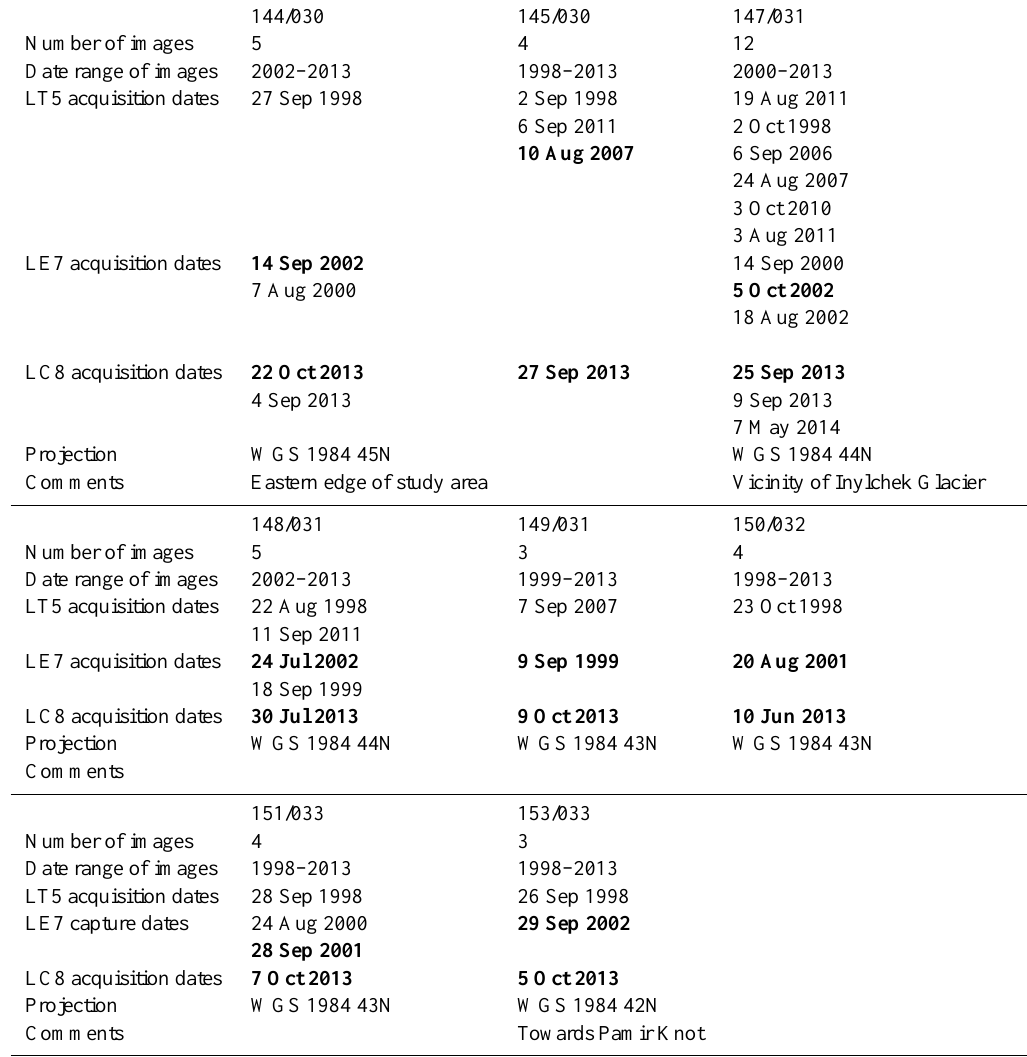
Table 1. Data table listing Landsat acquisition dates used in this study. Organized by WRS2 Path/Row combinations. Bold dates indicate images used for velocity